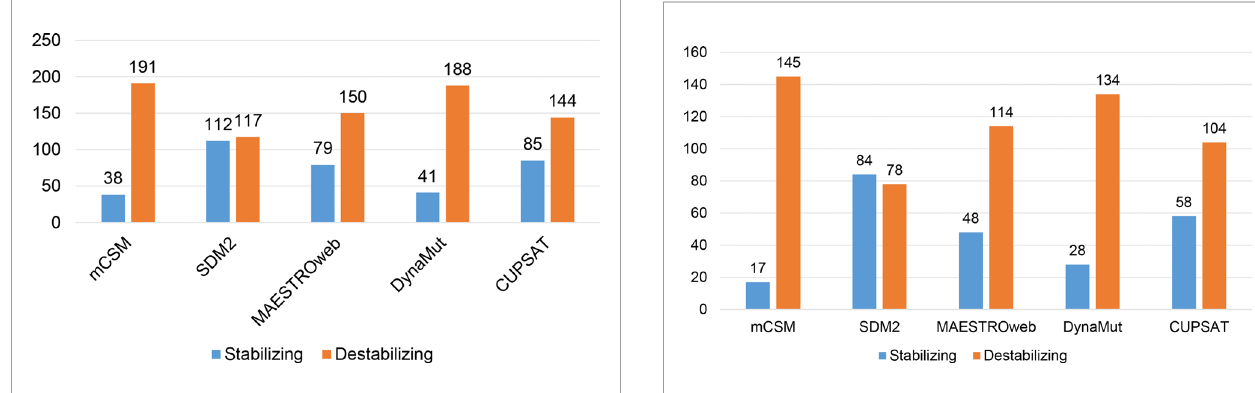
FIGURE 4 | Distribution of stabilizing and destabilizing mutations in SARS- CoV-2 Nucleocapsid protein predicted by structure-based